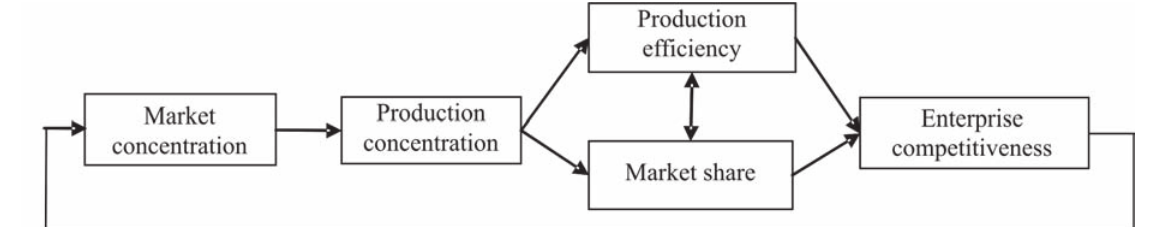
Fig 1. The relationship between market concentration and enterprise